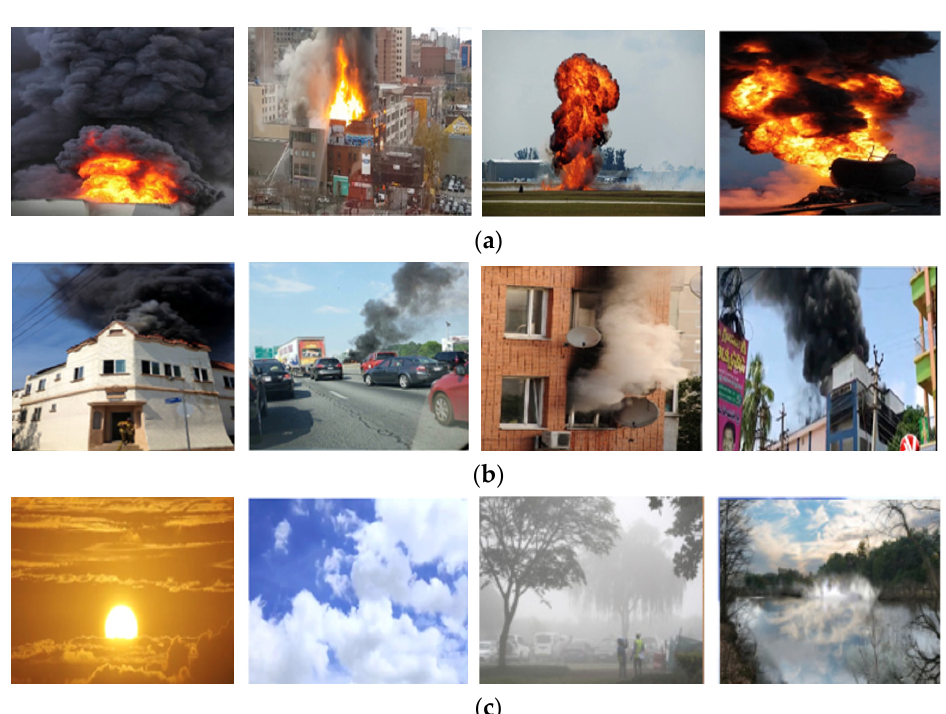
Figure 4. Sample images for training Faster R-CNN; ( a ), ( b ), and ( c ) are fire, smoke, and non-fire images, respectively [3].